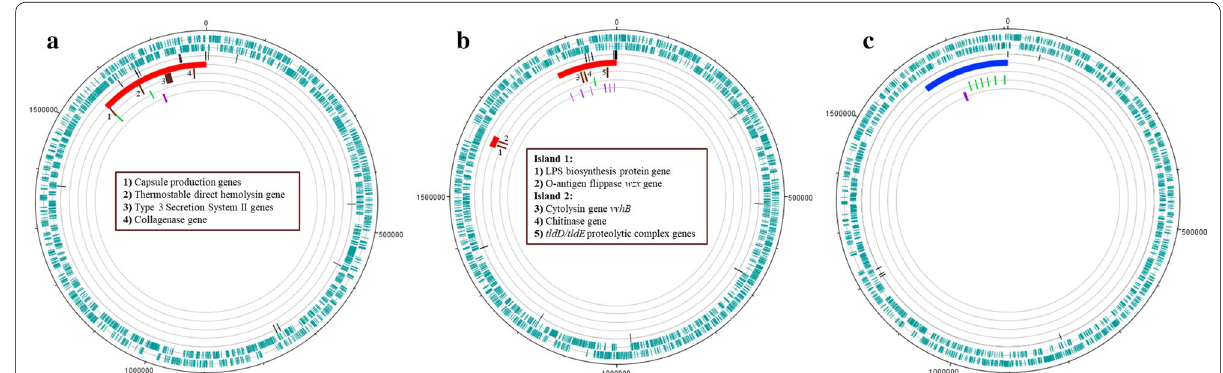
Fig. 1 a – c Circular presentation of the second chromosome of a Vibrio parahaemolyticus environmental strain TS-8-11-4, b Vibrio vulnificus environmental strain WR-2-BW, and c Vibrio diabolicus environmental strain JBS-8-11-1. Track 1, forward coding sequences; track 2, reverse coding sequences; track 3, tRNA genes; track 4, red, pathogenicity islands, blue, genomic fitness islands; track 5, virulence and virulence-associated genes; track 6, genes involved in toxin–antitoxin systems; track 7, mobile genetic elements. Virulence and virulence-associated genes are numbered and are defined via the center text